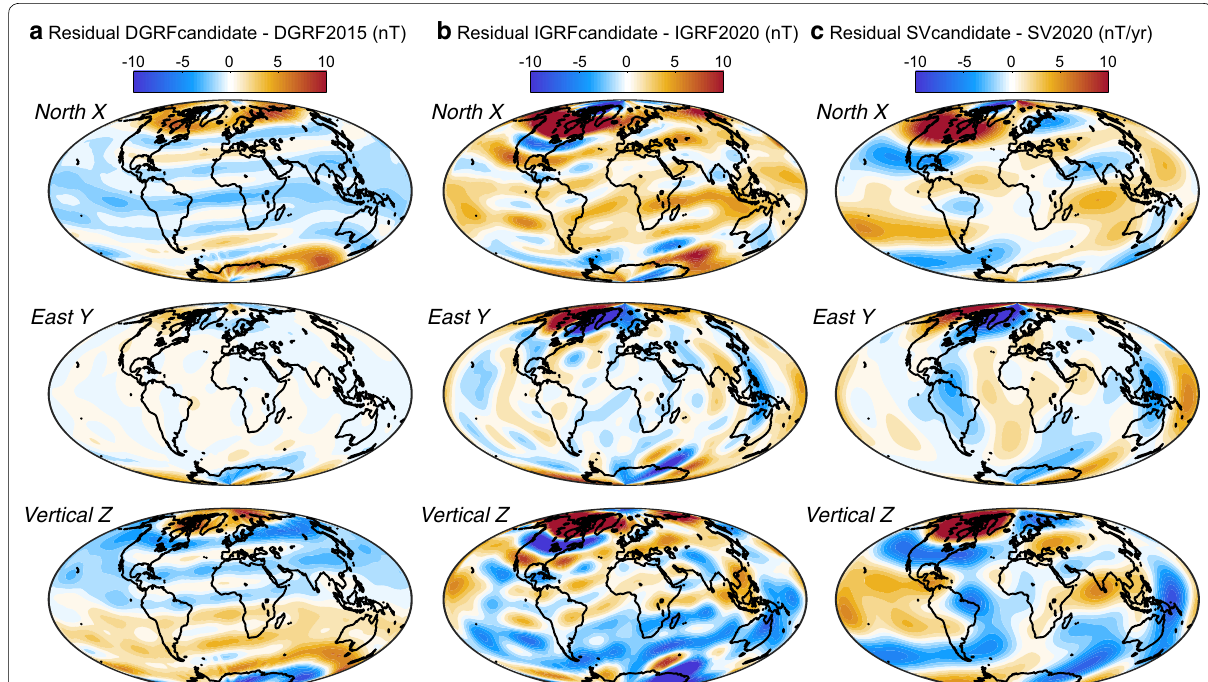
Fig. 9 Maps of vector components for the residuals obtained by the comparison of our candidates and the final IGRF‑13 products. a DGRF residuals, b IGRF residuals, c secular variation residuals